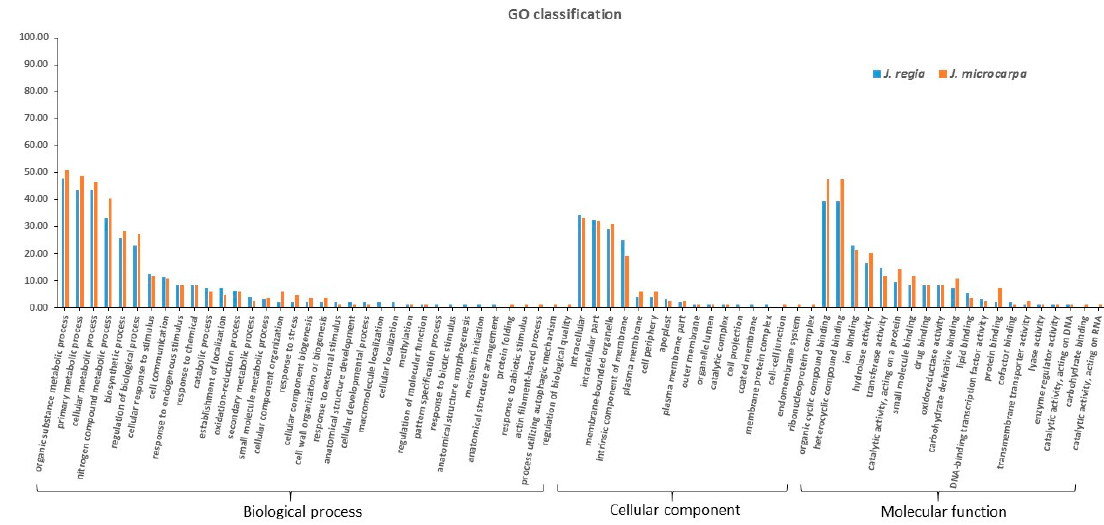
Figure 1. Gene Ontology (GO) functional classification of microRNA (miRNA) target genes identified in the J. regia and J. microcarpa genomes. y -axis represents the percentage of the number of target genes.